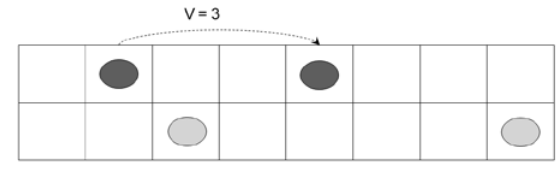
Fig. 1. The computational domain in the CA model